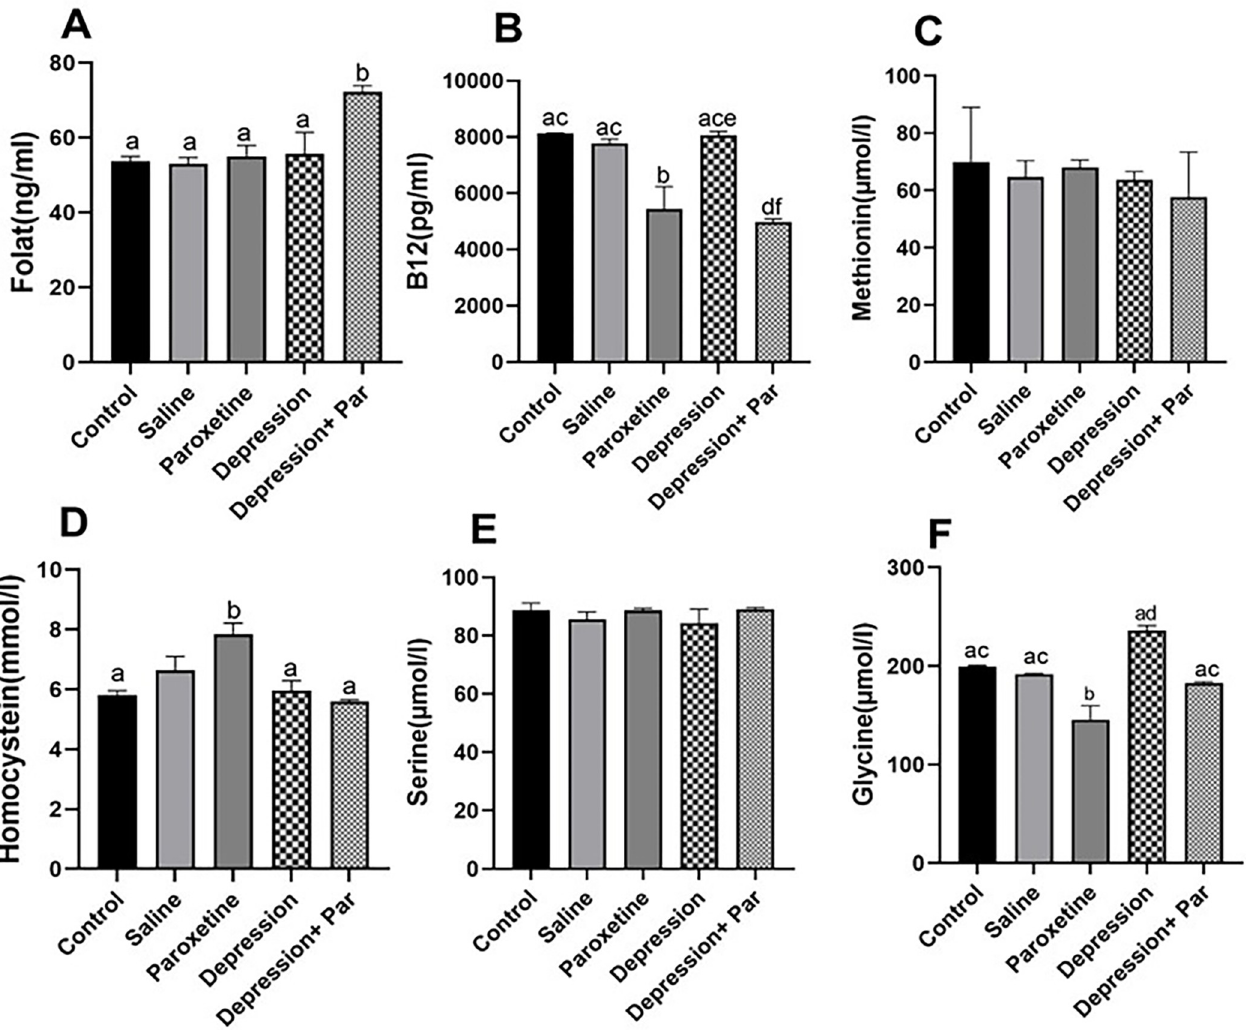
Fig 7. Evaluation of one-carbon cycle indicators between mouse groups (N=3 for each group). Bars with different superscript letters are significantly different (p < 0.05).